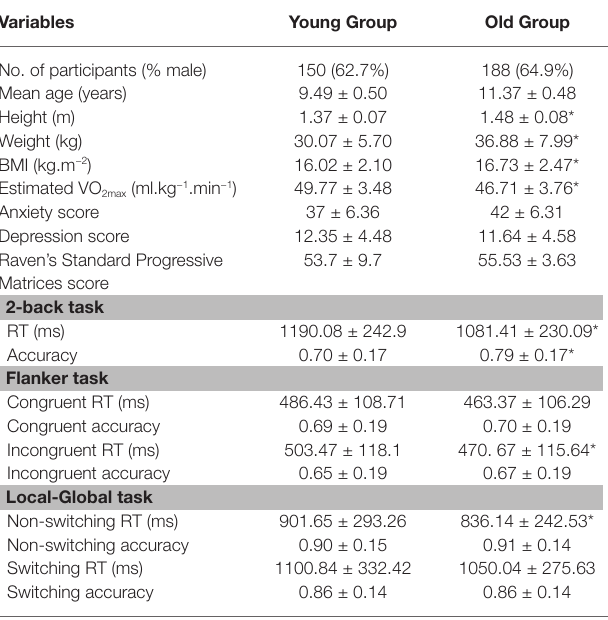
TABLE 1 | Preadolescents’ demographic and cognitive-related characteristics of the Young and the Old Groups (mean ± SD). Variables Young Group Old Group No. of participants (%